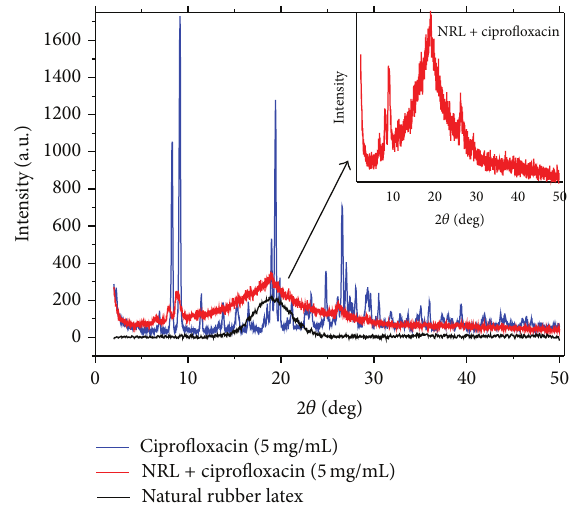
Figure 2: X-ray diffraction pattern of NRL (black line), cipro- floxacin powder (blue line), and NRL membrane prepared with 5 mg/mL of ciprofloxacin (red line).